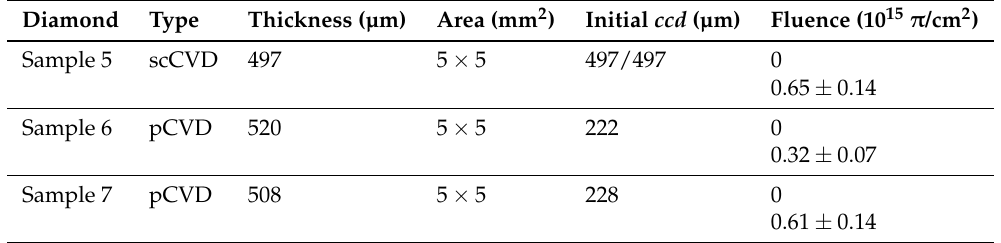
Table 3. Properties of diamonds irradiated with pions and the fluence they received. The initial unirradiated Charge Collection Distance ( ccd ) values for the scCVD diamond sample are given separately for positive and negative bias polarity at 1V/µm, since the detector collects all the charge at a bias voltage of 200V. For Samples 6 and 7, only one bias polarity was measured for the unirradiated samples. For these samples, the initial ccd values are listed for comparison but were not used in the